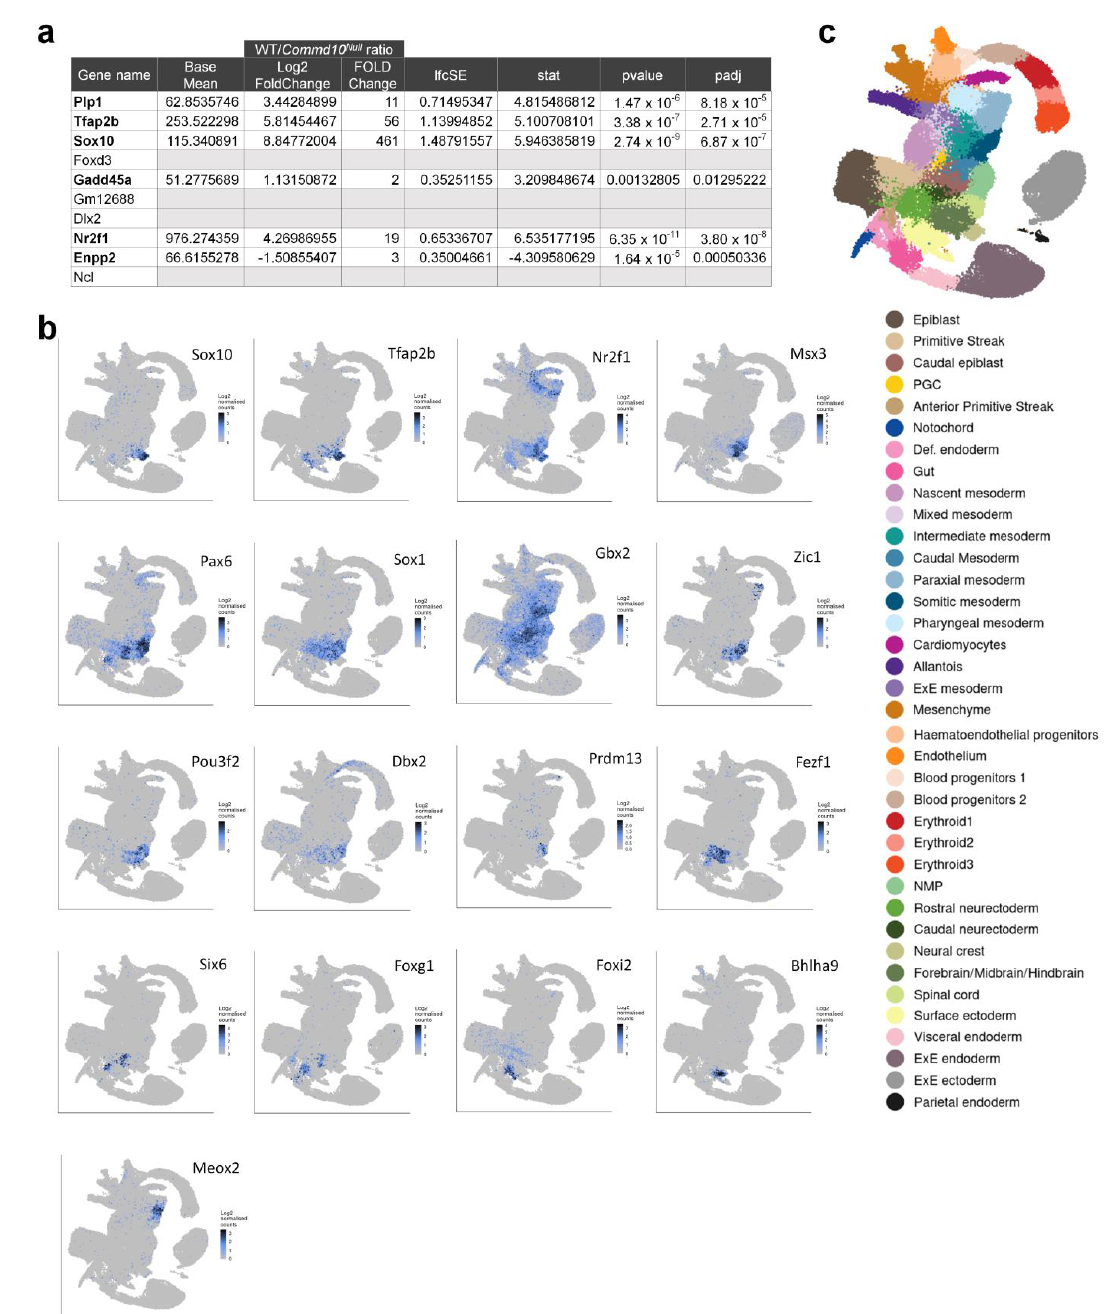
Figure 3. Six of the top ten neural crest-specific markers are differentially expressed in WT versus Commd10 Null embryos. ( a ) Table listing the top ten neural crest-specific markers, genes that are expressed in the neural crest more highly than in any other cell type. Six genes with differential expression in WT and Commd10 Null embryos are shown in bold font. ( b ) Tissue distribution of mRNA expression of different transcription factors in WT embryos during early embryogenesis in the molec- ular map of whole dataset, as described in ( c ). ( c ) Legend for ( b ) annotating cell clusters by different colors, and a single-cell molecular map of mouse gastrulation and early organogenesis [22] up to day E8.5 of embryogenesis. All presented plots were generated on a single-cell molecular map of mouse gastrulation and early organogenesis at https://marionilab.cruk.cam.ac.uk/MouseGastrulation2018/ (accessed on 2 September